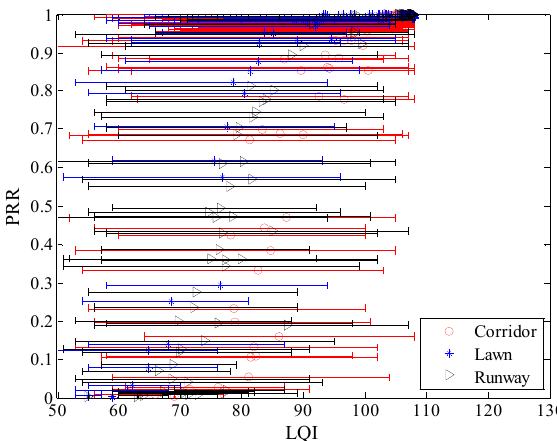
Figure 19. LQI vs. PRR in different environments.